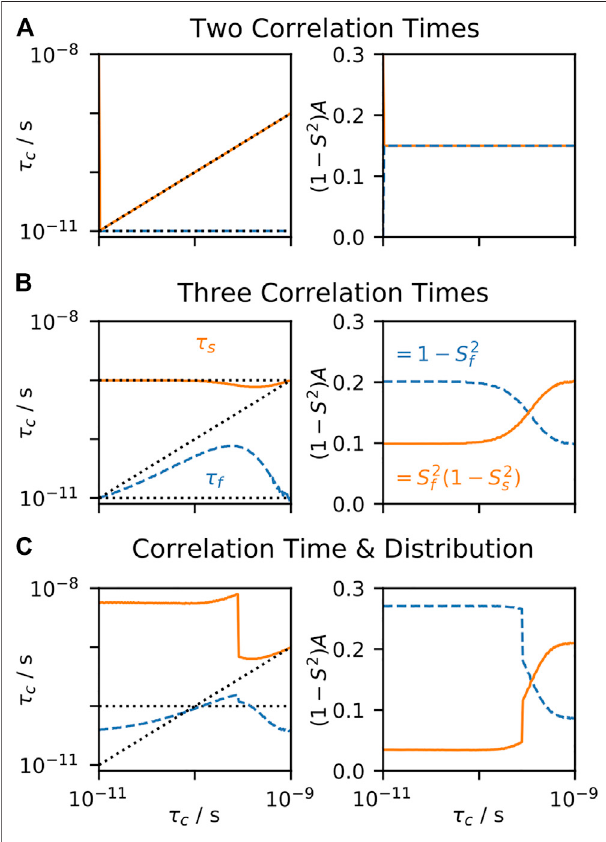
FIGURE4| EMFparametersasafunctionofinputcorrelationtime(solution- state). For each plot, a data set is calculated, using the set of experiments from Clore et al. (1990), and the resulting rate constants are fi tted using the EMF approach. For all plots, τ M (cid:2) 8.3 ns, and the input (cid:10) 1 − S 2 (cid:11) (cid:2) 0.3. In each subplot,the fi ttedcorrelation times (left) andamplitudes (right) areshown,asa function of an input correlation time ( x -axis). In (A) , the input correlation function has two correlation times (with equal amplitudes), with one fi xed at 10 ps, and theother swept.In (B) ,theinputcorrelation functionhasthreecorrelation times, two fi xed at 10 ps and 1 ns, and the third is swept. In (C) , a log-Gaussian distribution of correlation times is used ( μ (cid:2) 100 ps, σ (cid:2) 0.75 orders of magnitude), and a single correlation time is swept. Black dotted lines show the input correlation times (left plots)